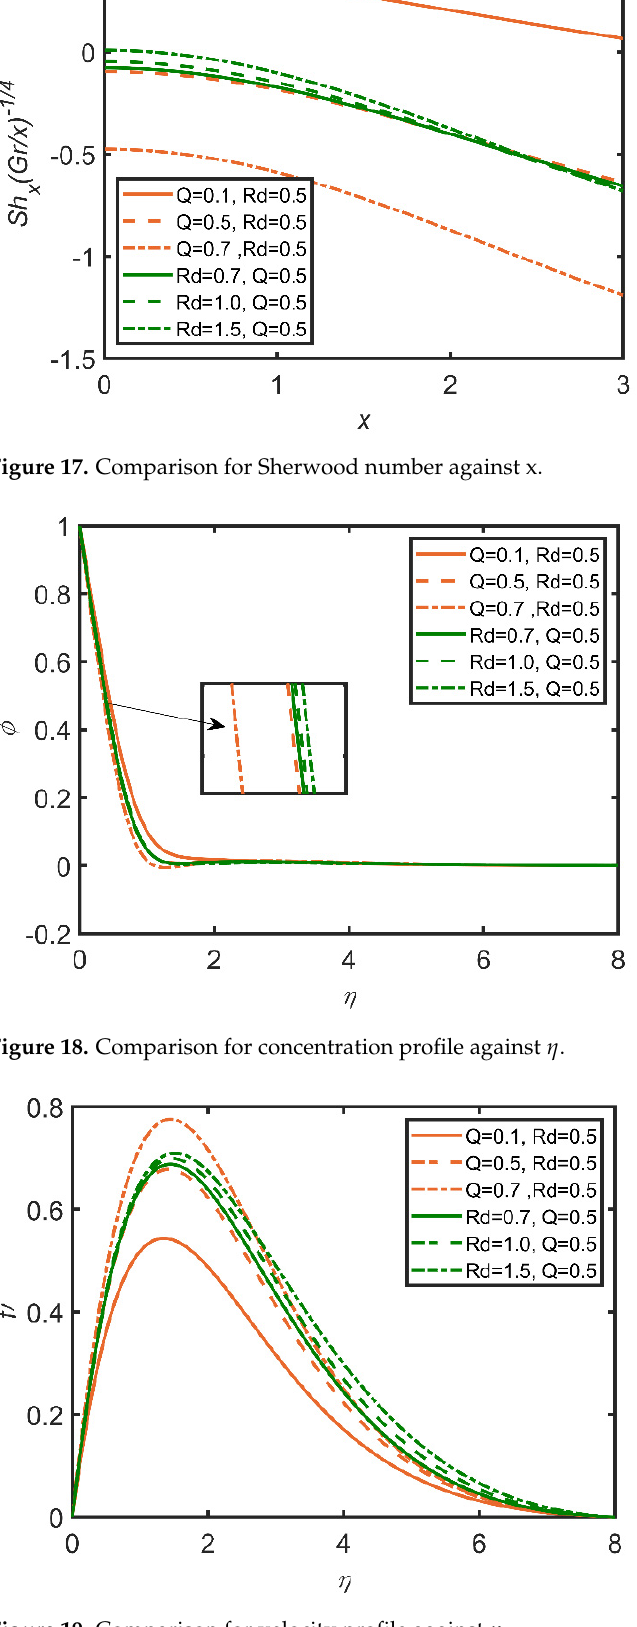
Figure 19. Comparison for velocity profile against 𝜂 .